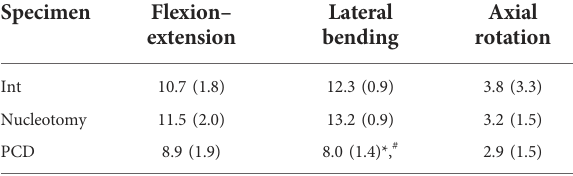
TABLE 1 ROM values for different conditions ( n =8, ±SD, degree, °).